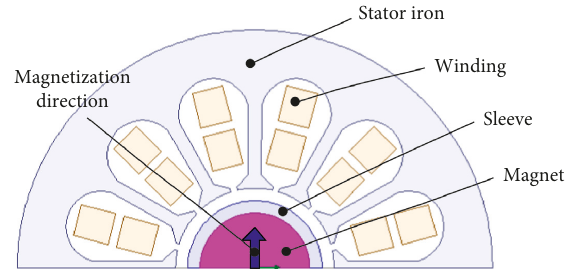
Figure 1: Cross section of the ultra-high-speed